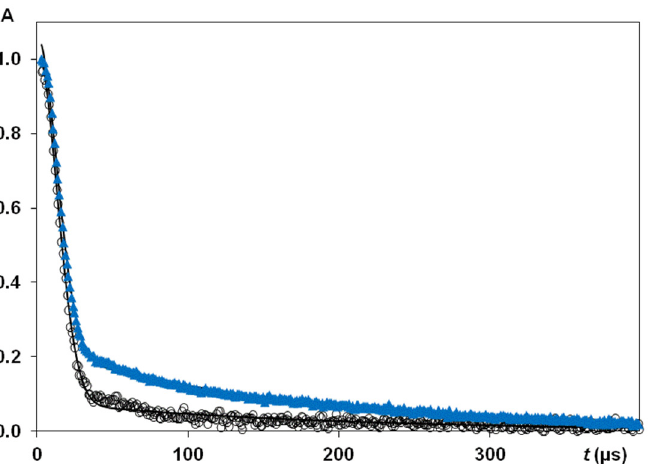
Figure 10. The NMR signals measured (T = 300 K) in solid echo experiments on untreated silk fibres B. mori at HL = 0.08 (blue, triangles) and silk fibres B. mori after step (5–7 ◦ ) heating samples in the NMR probe to 350 K (black, circles). After heating, the silk sample returned to 300 K and measured with the same orientation 0 ◦ . The data were normalised per maximum signal in each experiment. A (arb. units) is the signal intensity. Solid lines are the fits of the experimental data to the sum of exponential function and Gaussian-sinc expression: f ( t ) = P 1 · exp [ − a 2 · t 2 /2] · [ sin ( b · t )/ b · t ], The details are provided in Section 2.5. NMR Methods.